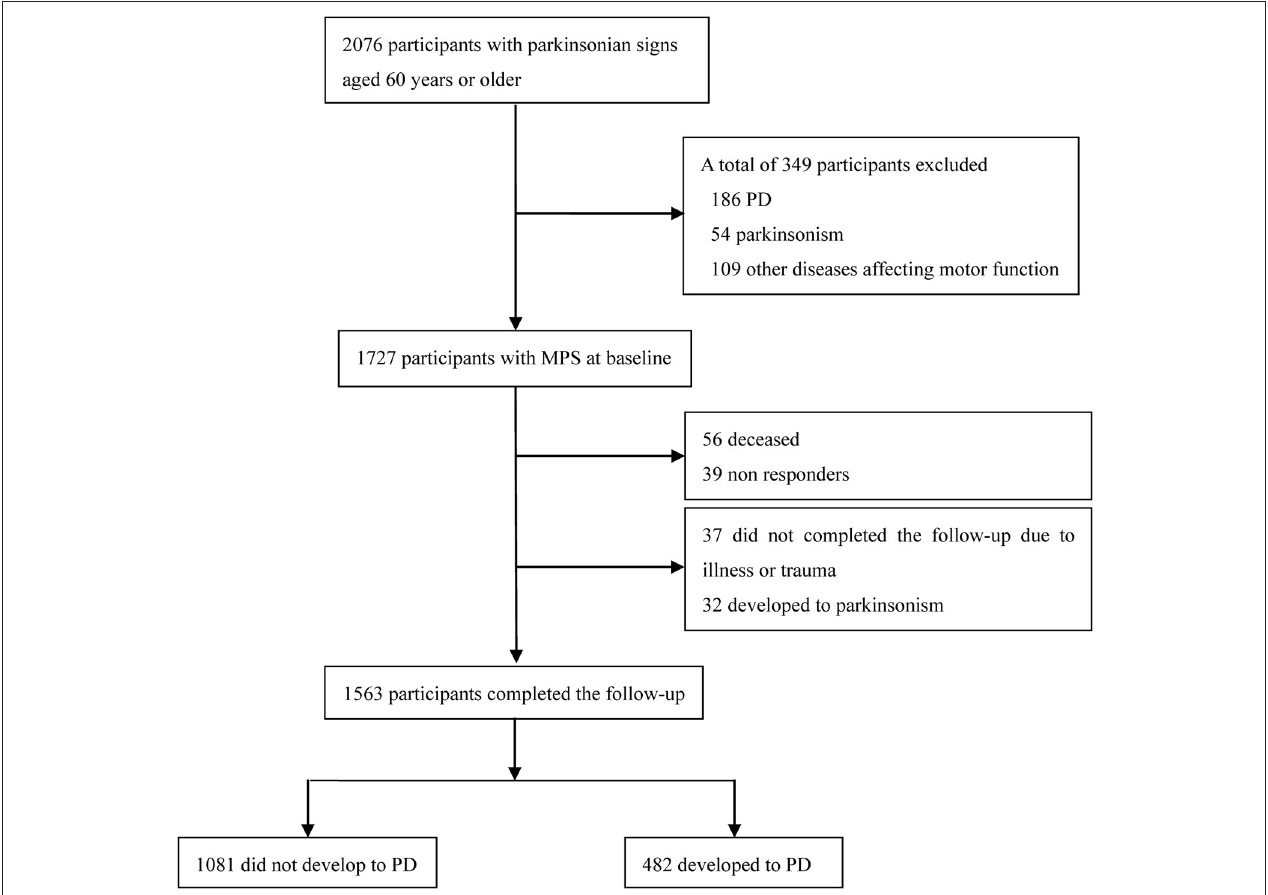
FIGURE 1 | Flowchart of patient recruitment in this study. PD, Parkinson’s disease; MPS, mild parkinsonian